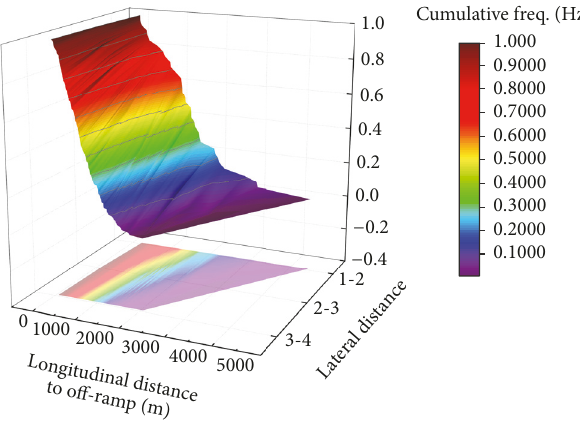
Figure 9: Spatial attributes with respect to cumulative frequency of